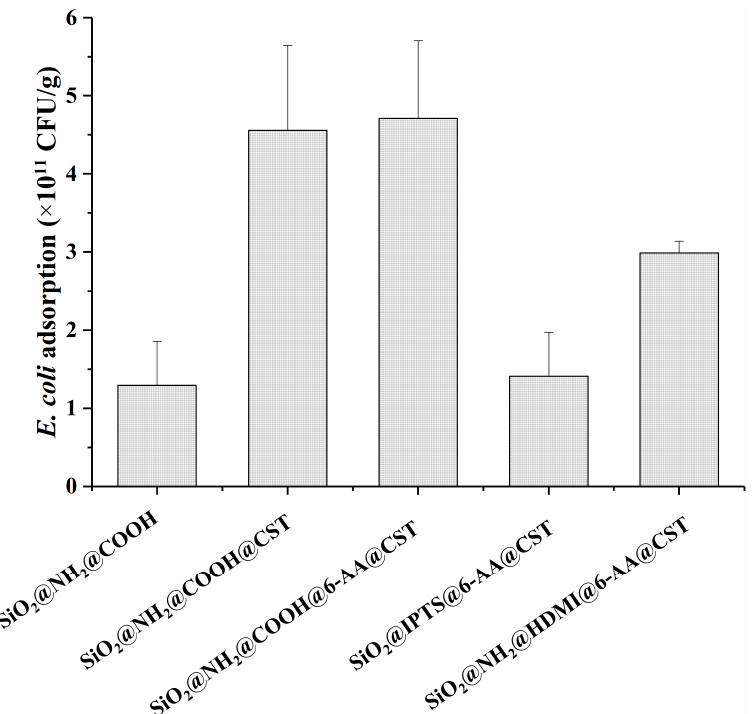
Figure 1. Effect of linkers and linking modes on the adsorption of E . coli by different modified silica gel.